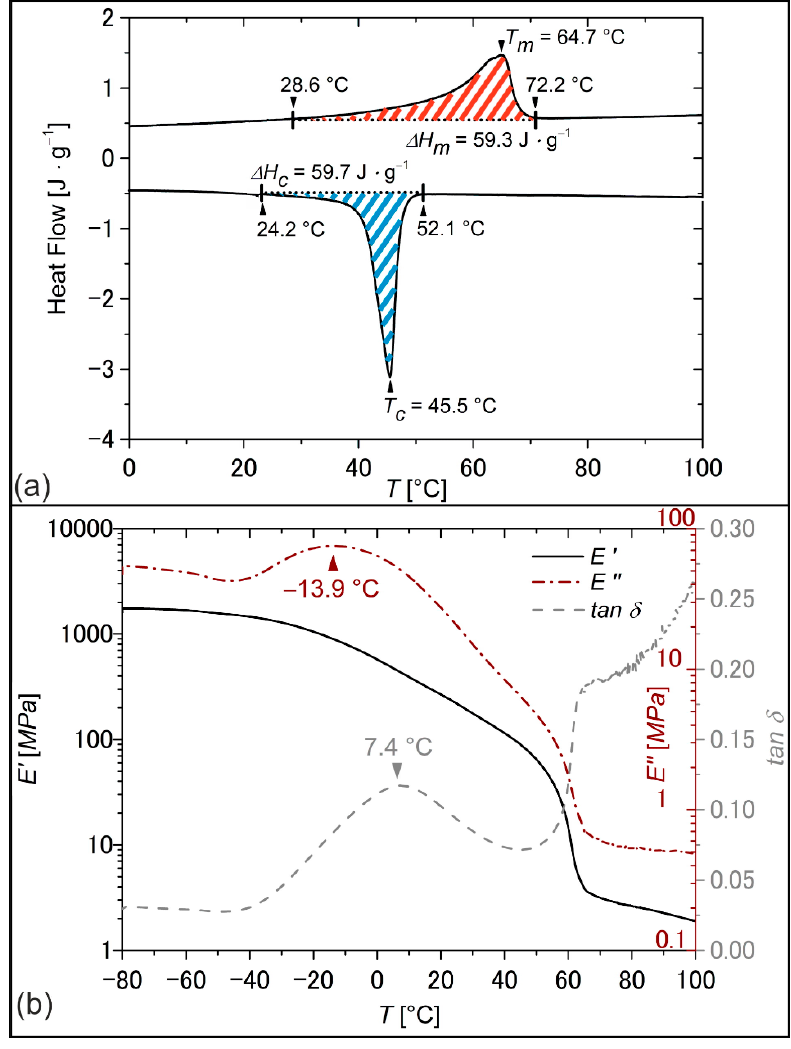
Figure 5. Thermal and thermomechanical properties of PDA-based PEU as determined by DSC ( a ), second heating and cooling with temperature rates of 10 ◦ C · min − 1 , the enthalpies of melting ∆ H m , red dashed area, and crystallization c , blue dashed area, are included) and DMA ( b ), the temperature dependence of storage modulus E (cid:48) , loss modulus E ” and loss factor tan δ at a heating rate of 3 ◦ C · min − 1